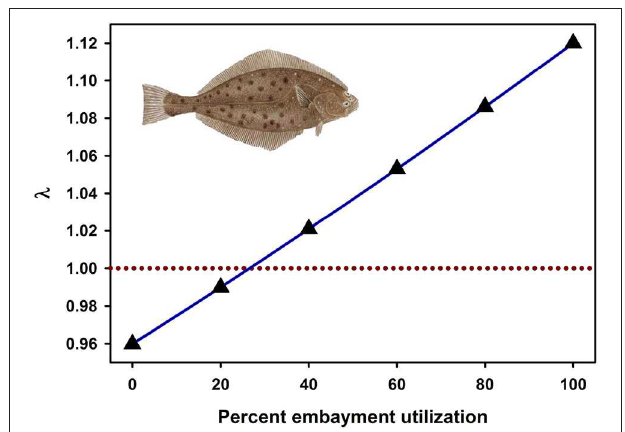
FIGURE 7 | Fitness of a California halibut Paralichthys californicus population resulting from the percentage of juvenile fish that utilized exposed coast vs. embayment habitat as nurseries during 1987, 1988, 2002, and 2003. Dashed line represents a stable population ( λ = 1). Figure adapted with permission (Inter-Research) from Fodrie et al. (2009). Image from http://www.